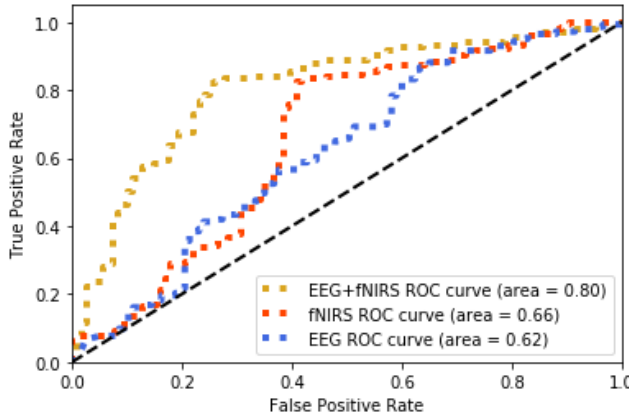
EEG or fNIRS employed for all image-content trials Brain Sci. 2020 , 10 , x FOR PEER REVIEW 13 of 20